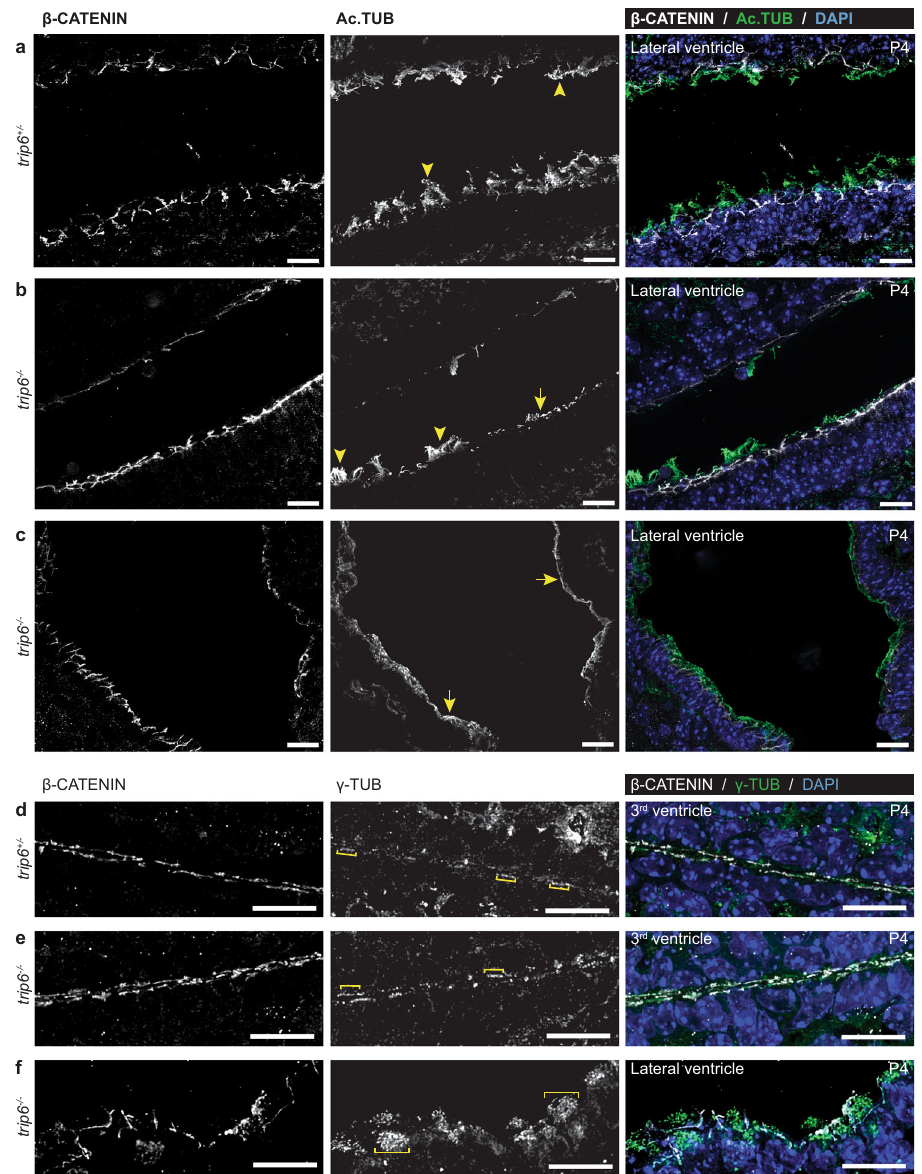
Fig. 5 Defective ciliation of ependyma in trip6 − / − mice. Deconvolved immuno fl uorescence microscopy images of the ependyma of three trip6 − / − and two control trip6 + / − mice (all at P4) depict, in high spatial resolution, adhesions (labeled by an anti- β -catenin antibody), cilia (anti-acetylated α -tubulin labeling), and basal bodies (anti- γ -tubulin labeling). An animated 3-D reconstruction of the images is presented in Supplementary Movies 3, 4, and 5. There are no obvious adhesion defects in the ependyma, neither in the LV ( a c f . b , c , f ) nor in the 3 rd ventricle ( d cf . e ), as demonstrated by comparison of control ( a , d ) with trip6 − / − ( b, c , e , f ) specimens ( β -CATENIN). In contrast, in the LV, defective ciliogenesis in trip6 − / − mice of mild ( b ) or severe ( c ) phenotype (degree of cilia absence) is demonstrated by ependyma areas presenting with a thin layer of acetylated α -tubulin labeling (Ac.TUB, arrows). For comparison, normal cilia bundles are indicated by arrowheads, in control ( a ) and trip6 − / − ( b , c ) specimens. (see also Fig. 7d cf . e, for higher resolution images of cilia). Regular formation and ventricular localization of basal bodies, in trip6 − / − ependymal cells ( e , f ) of 3rd and LVs, is visualized by the punctate γ -tubulin staining pattern. The brackets indicate clusters of basal bodies within single ependymal cells ( γ -TUB; d – f ). Scale bars: 10 μ